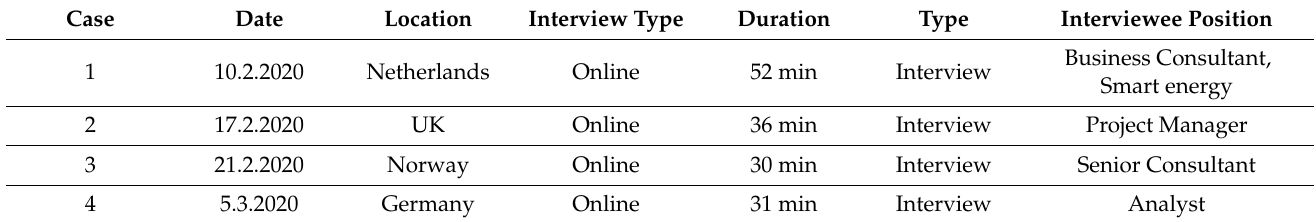
Table 2. Interviews from European LFM